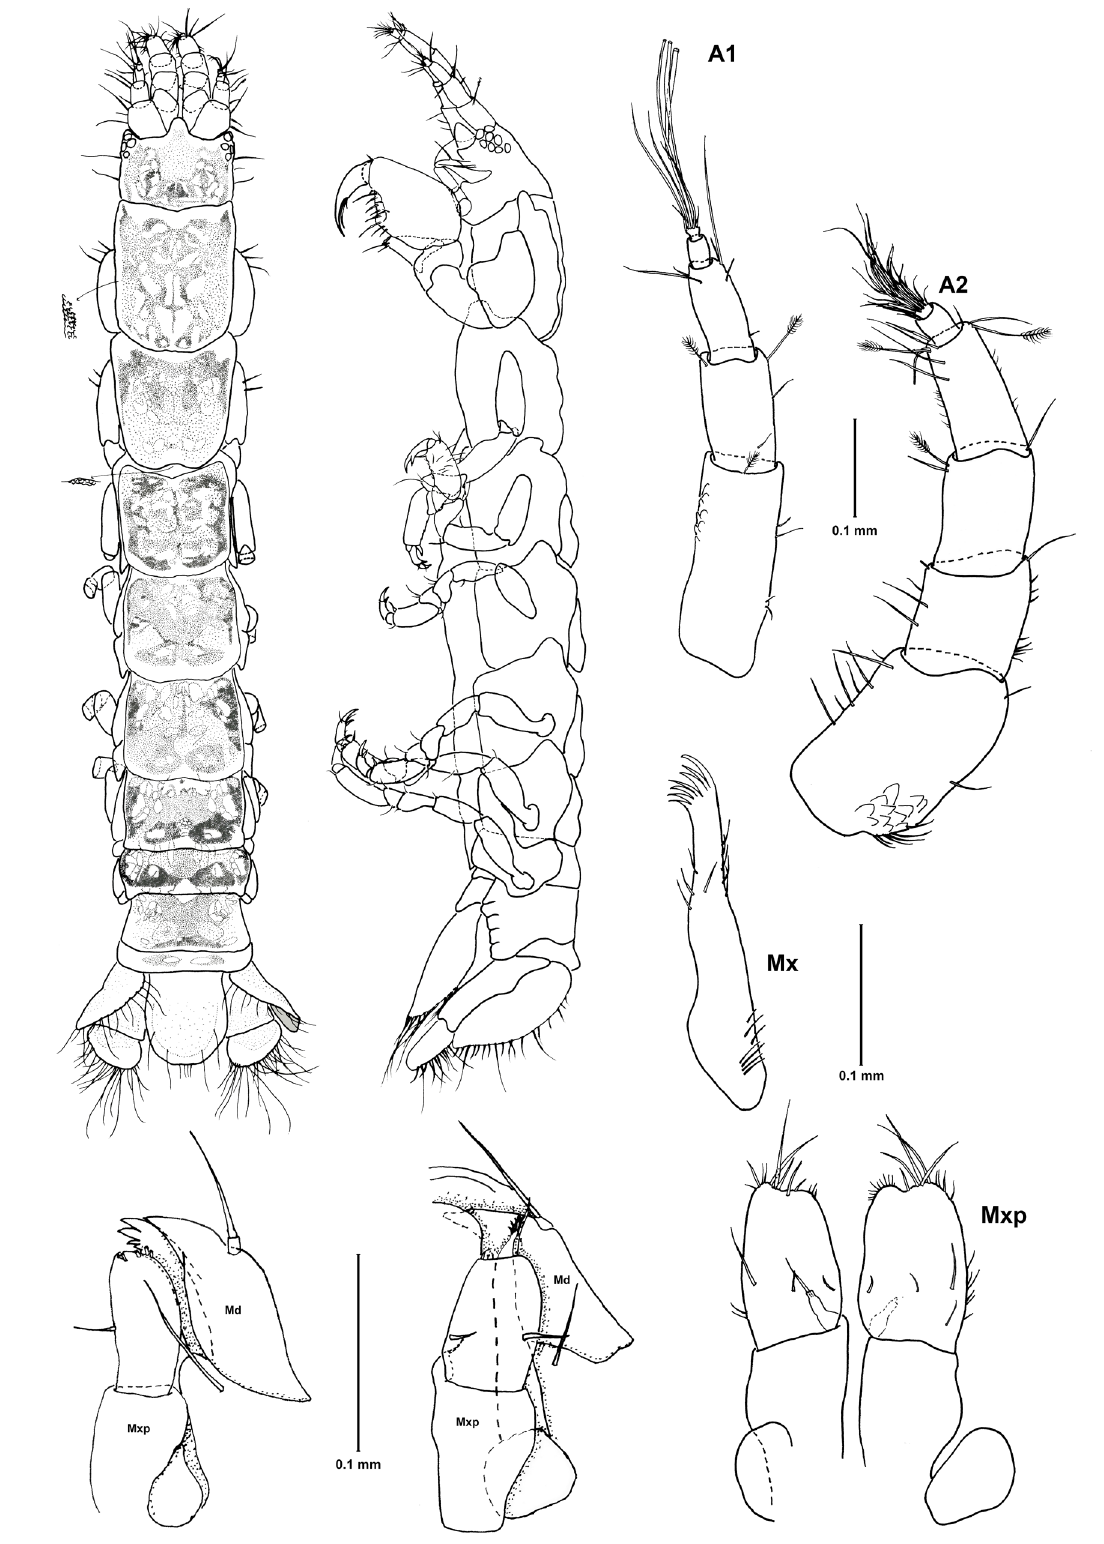
Fig. 14. Pendanthura bangkaensis sp. nov., holotype, ♀, in dorsal and lateral view (3.4 mm) (MZB Iso 104). Abbreviations: A1 = antenna 1; A2 = antenna 2; Md = mandible; Mx = maxilla; Mxp =